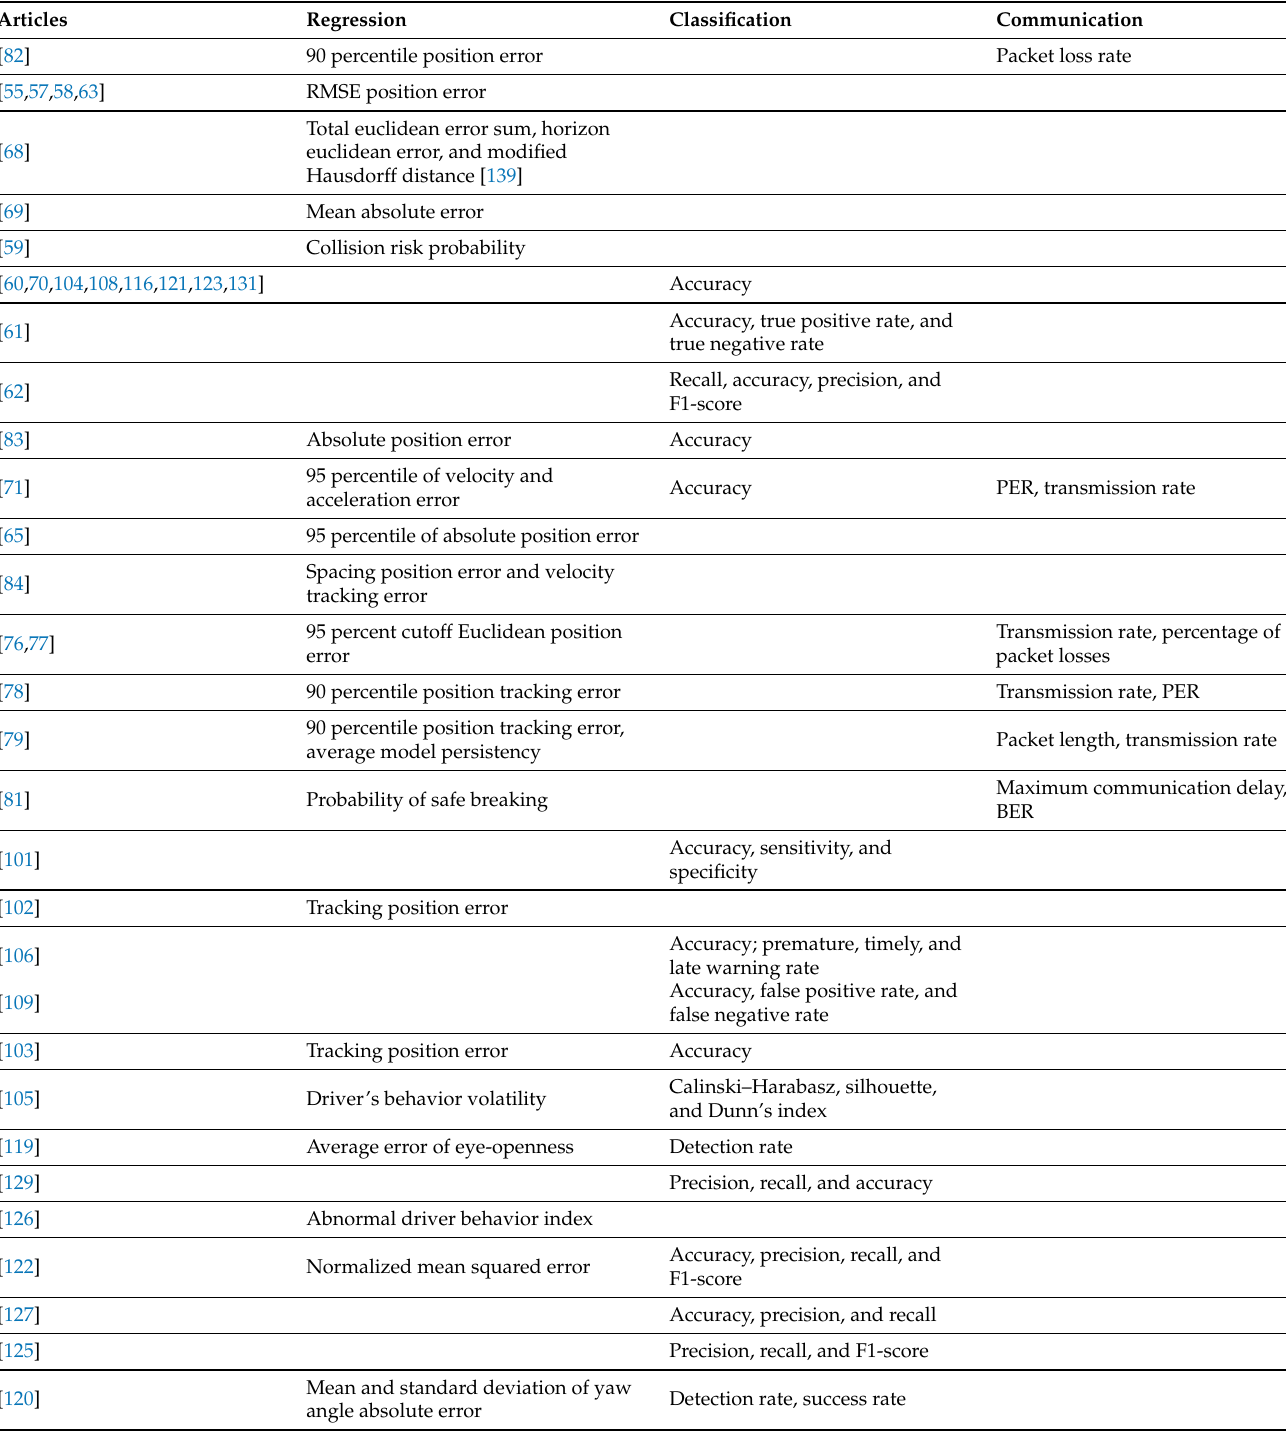
Table 6. Classification of the consulted works according to the evaluation metrics